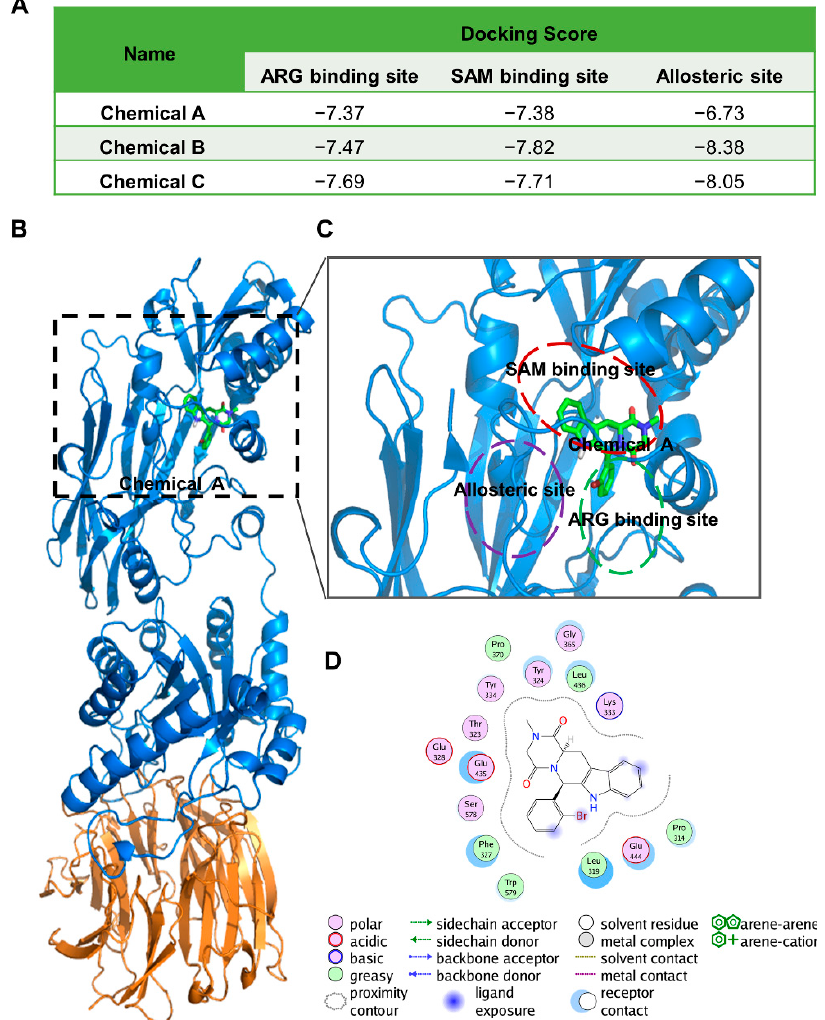
Figure 2. Chemicals A, B, and C could bind to PRMT5 through different binding modes. ( A ) The docking scores of chemicals A, B, and C at the three active sites of PRMT5. ( B – D ) Binding interactions of chemical A with human PRMT5. The overall structure of PRMT5:MEP50 complexed with chemical A at the SAM binding site is shown in ( B ). PRMT5 is shown as a blue ribbon, MEP50 is shown as an orange ribbon, and chemical A is shown as green sticks. Detailed binding interactions of chemical A with human PRMT5 are shown in ( C , D ).